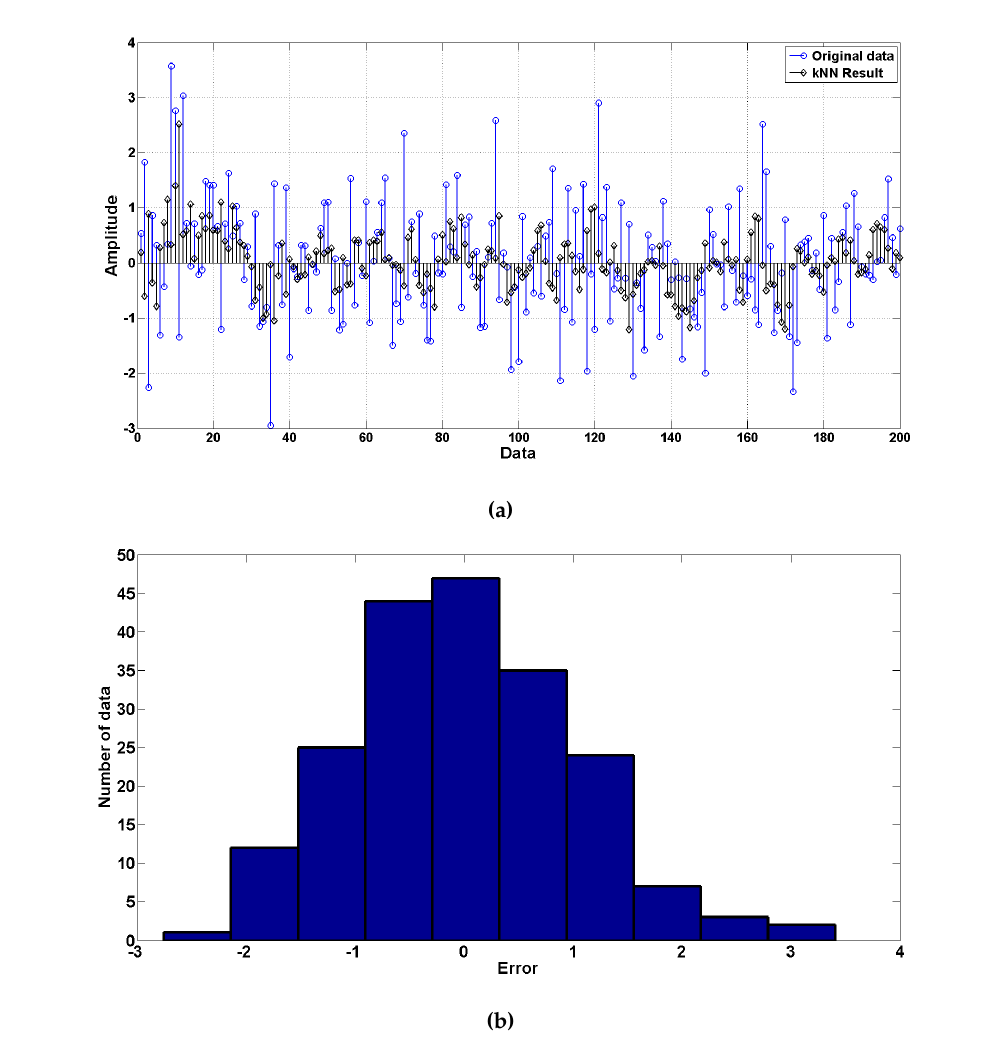
Figure 10. Performance of the kNN algorithm for a dataset of a size of 200. ( a ) Comparison of the data values and their prediction by the kNN algorithm; ( b ) histogram of the error distribution.